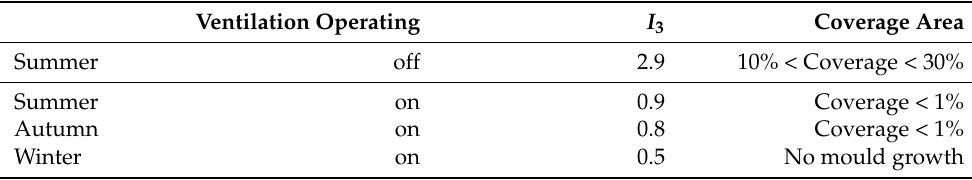
Table 2. Coverage area obtained from Johansson’s mould growth